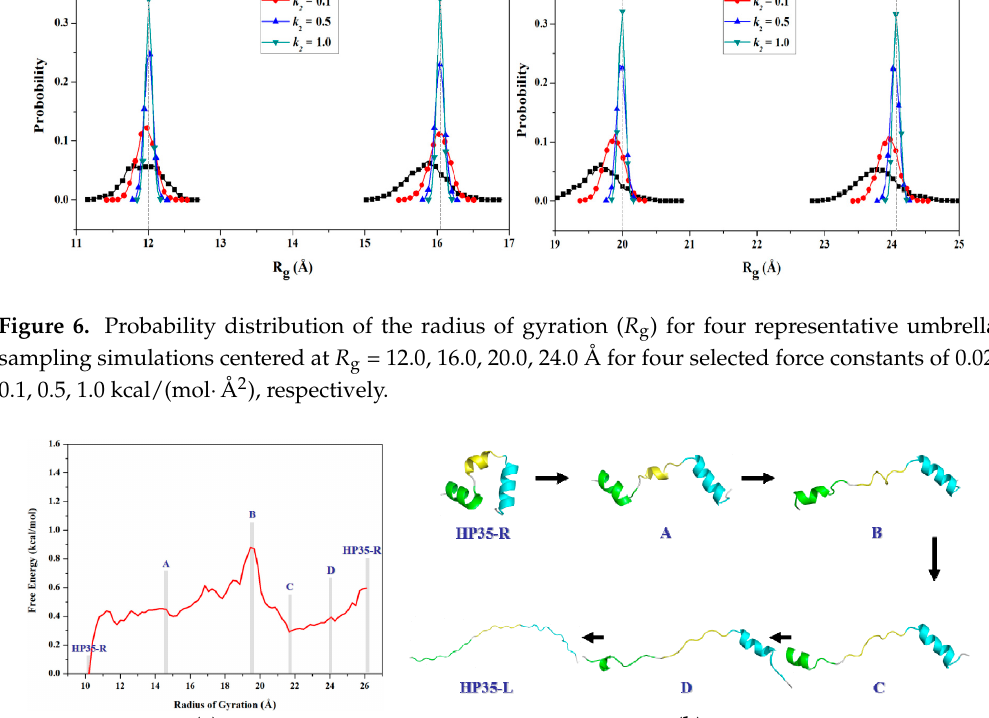
Figure 7. ( a ) Calculated free energy profile for the transition process of HP35-R to HP35-L along with the reaction coordinate of the radius of gyration ( R g ). The mazarine letters denote the different conformations; ( b ) The three-dimensional average structures for the six corresponding conformations of HP35-R, A, B, C, D and HP35-L presented in ( a ). The three helices of α 1, α 2 and α 3 for the simulated structure are colored in green, yellow and cyan, respectively.